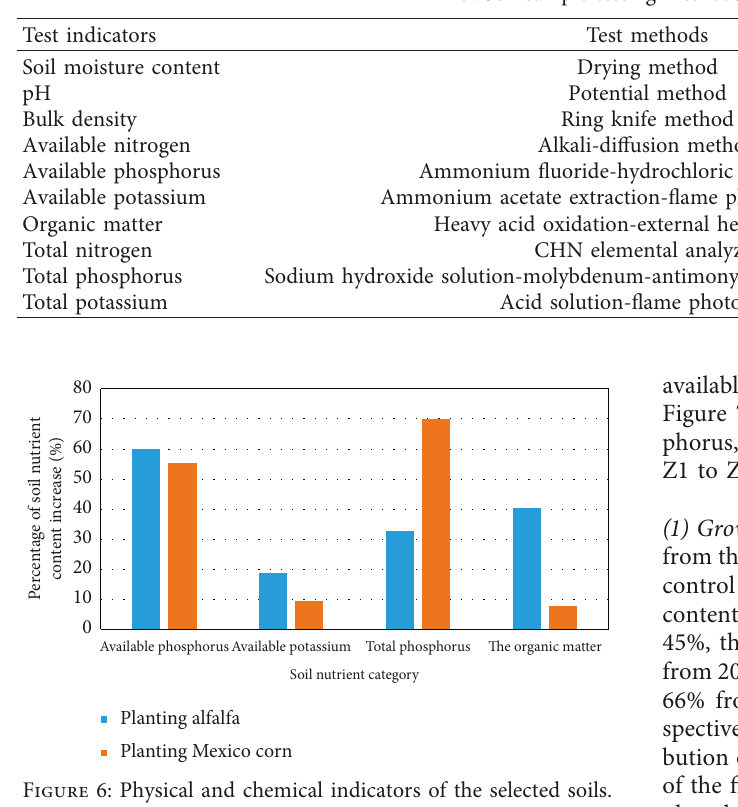
Figure 5: The collection and processing of soil samples. (a) Soil improvement test site. (b) Soil samples were collected with a ring knife. (c) Air-dry soil Table 5: Soil sample testing methods and standards.